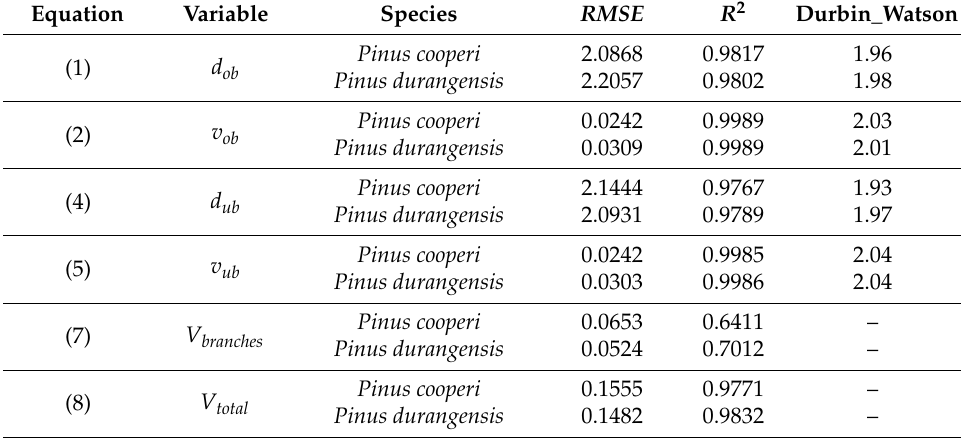
Table 2. Goodness of fit statistics for simultaneous fitting of the equation